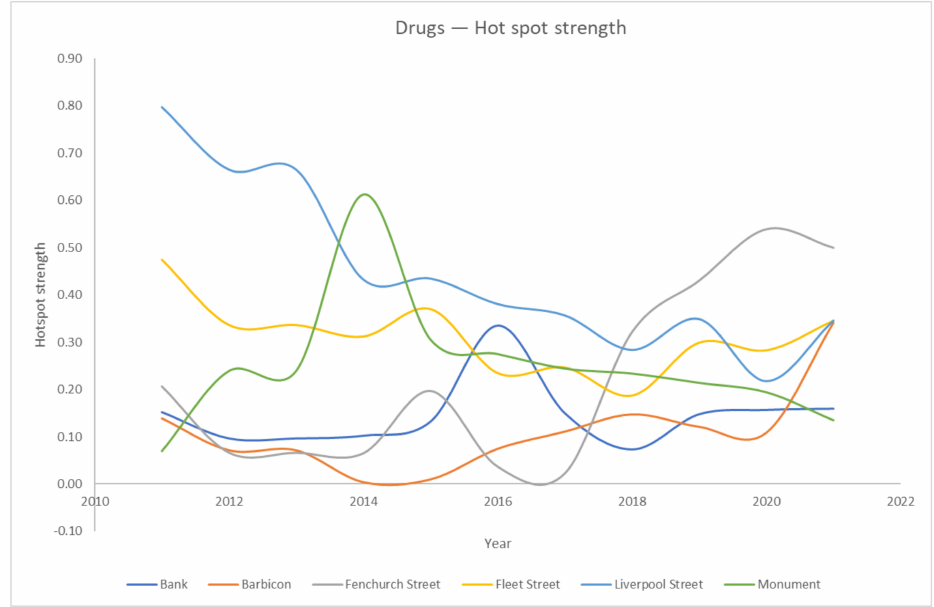
Figure 10. Trends of the hot spot strengths for drug crimes in all six clusters of the City of